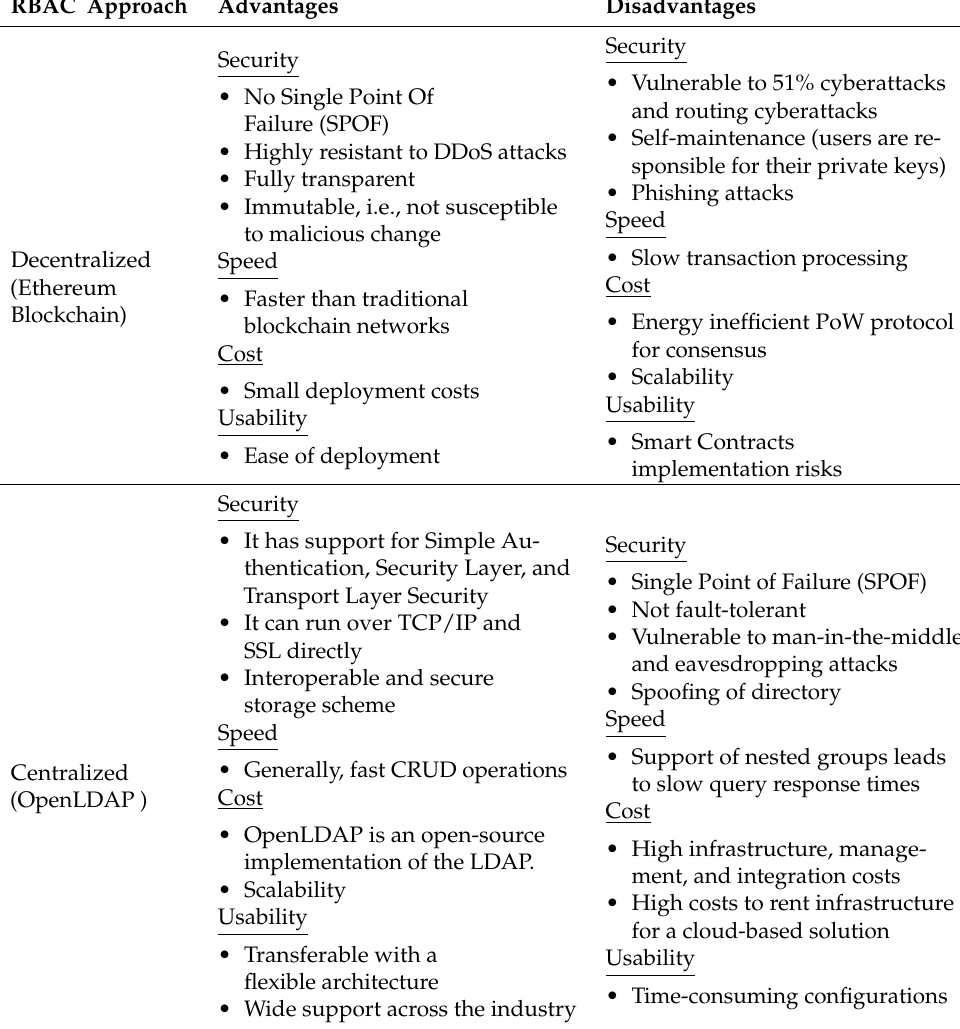
Table 2. Summary of the main advantages and disadvantages of the proposed RBAC approaches with respect to the aspects of Security, Speed, Cost, and Usability .